Question: Write a caption explaining this figure to a reader.
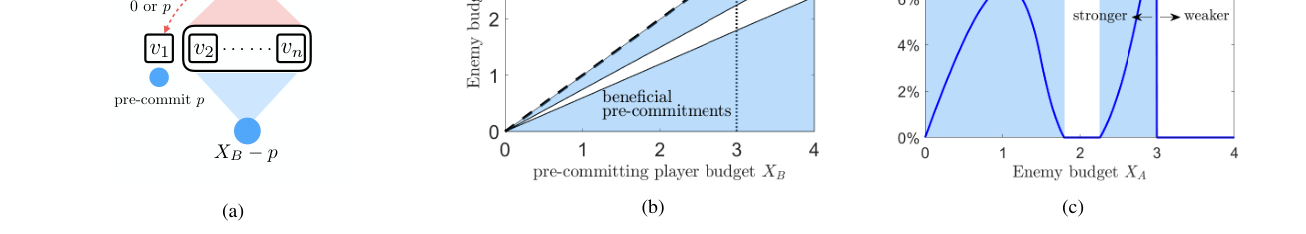
Answer: Scenario 1: Symmetric valuations. (a) Player B pre-commits to a single battleﬁeld of its choice. Our results establish that a pre- commitment to a single battleﬁeld is preferable over pre-commitments to multiple battleﬁelds of the same total value (Lemma 2.1). We thus seek necessary and sufﬁcient conditions for which pre-committing to a single battleﬁeld is beneﬁcial for some set of valuations v. (b) Parameter regimes where a player has an incentive to pre-commit (blue regions), i.e. to outperform its equilibrium payoff in the nominal GL game (Result 1). In this example, the value of the battleﬁeld that B can pre-commit to is restricted to not exceed 0.55. Here, we consider any set of valuations v whose total value is ﬁxed to one. A full characterization of regions is given in Theorem 2.1. Incentives only exist when the pre-committing player is stronger than its opponent. (c) The percent improvement in payoff that pre-commitments offer to player B over playing the nominal GL ga